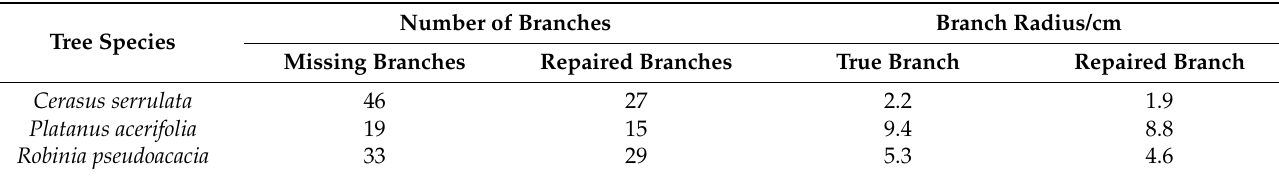
Table 4. Branch accuracy after repair and